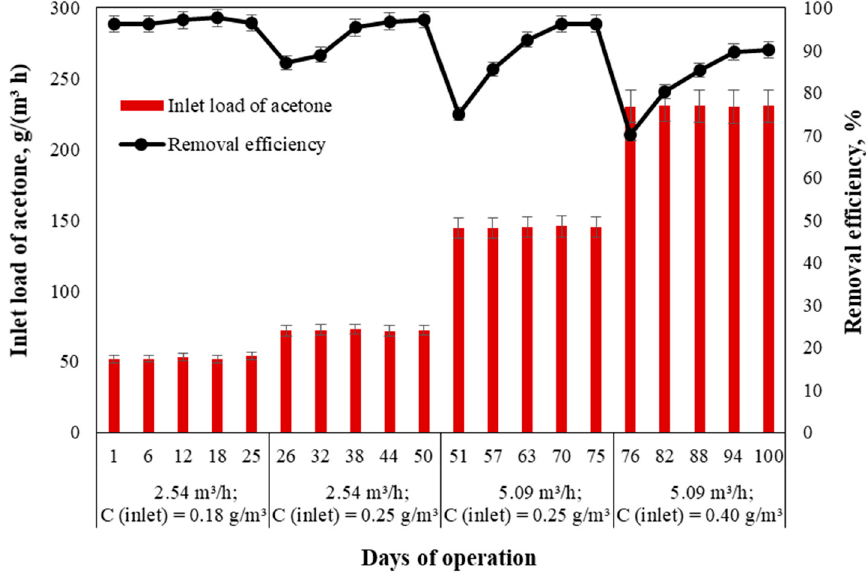
Figure 6. Influence of inlet acetone loading on the removal efficiency of the biotrickling filter.